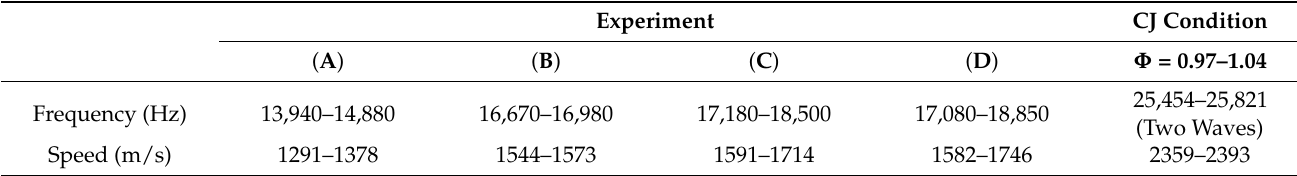
Table 6. Flow field frequency and detonation speed for each case shown in Figure